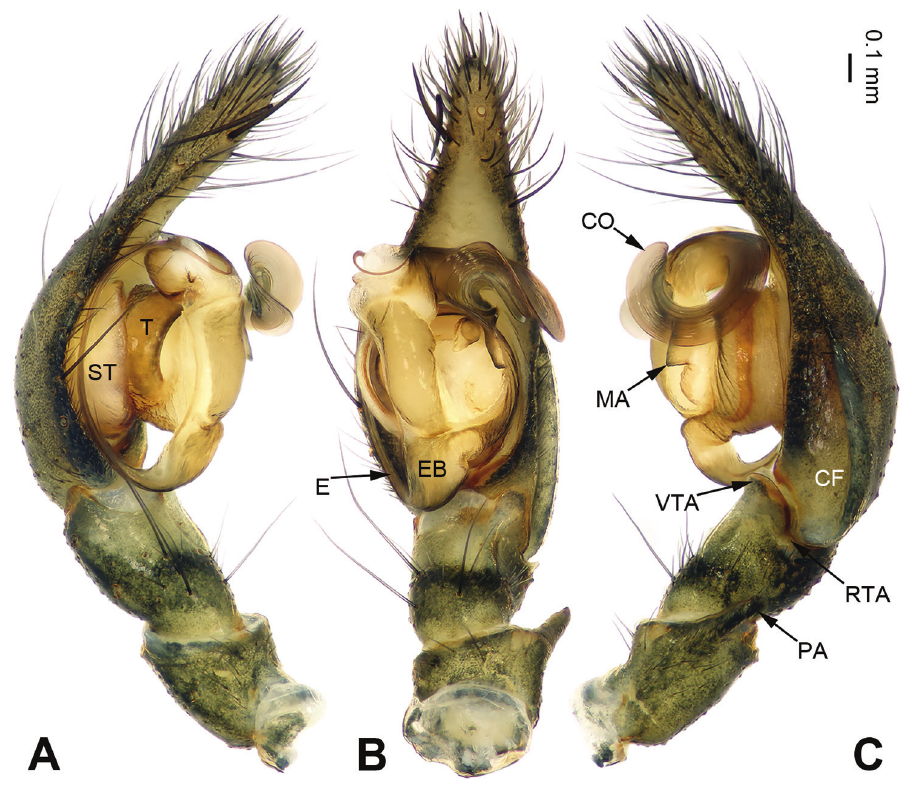
Figure 1. Male palp of Pireneitega zonsteini sp. n., holotype. A Prolateral B Ventral C Retrolateral. Scale bar 0.1